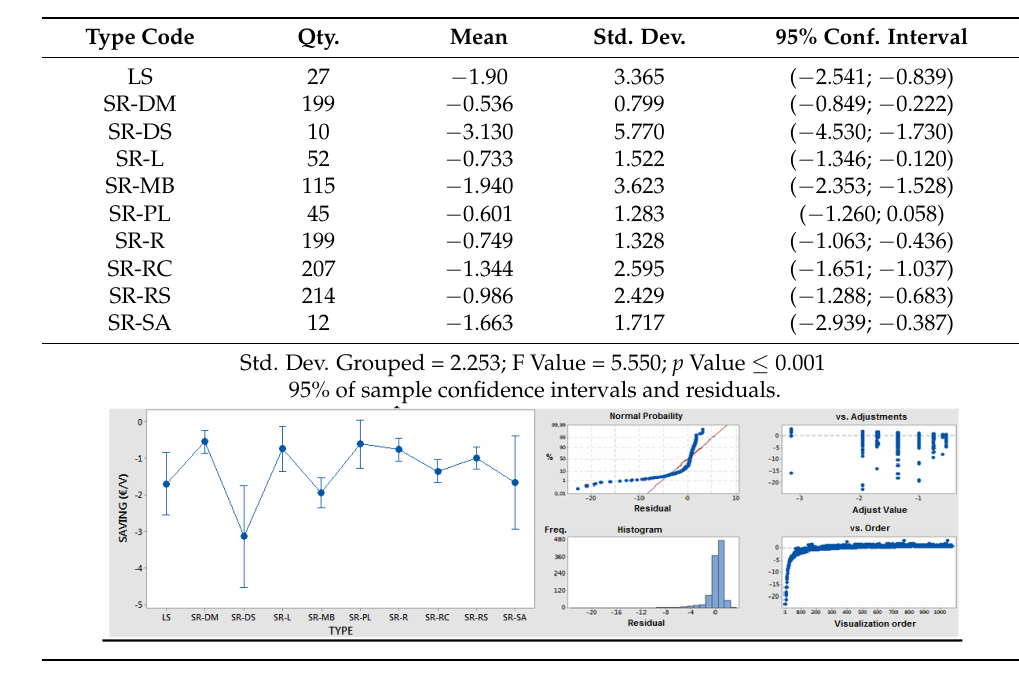
Table 6. ANOVA results for saving versus type.